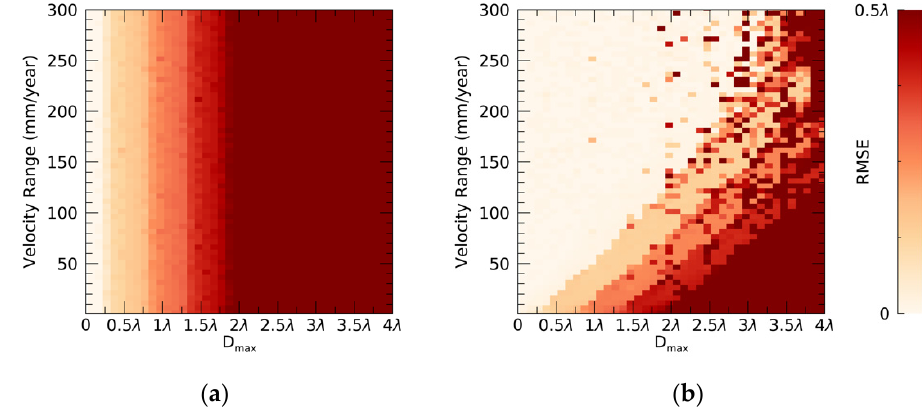
Figure 7. The results of the simulation for the velocity range: ( a ) the RMSE distribution with ConvPSI; and ( b ) the RMSE distribution of NN-PSI.